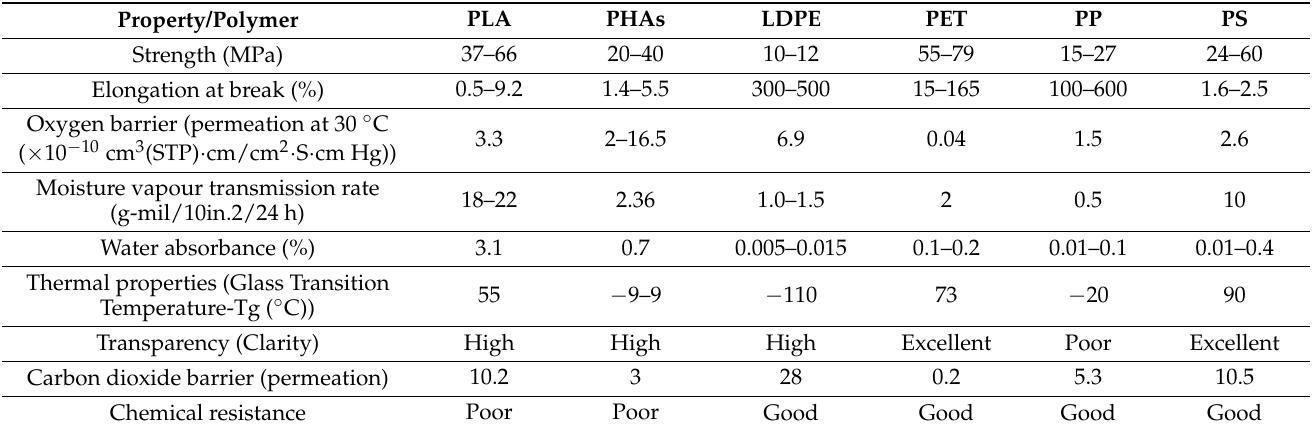
Table 3. Comparison of bioplastics’ (PLA and PHAs) properties to other common polymers used in product packaging. Data adapted from